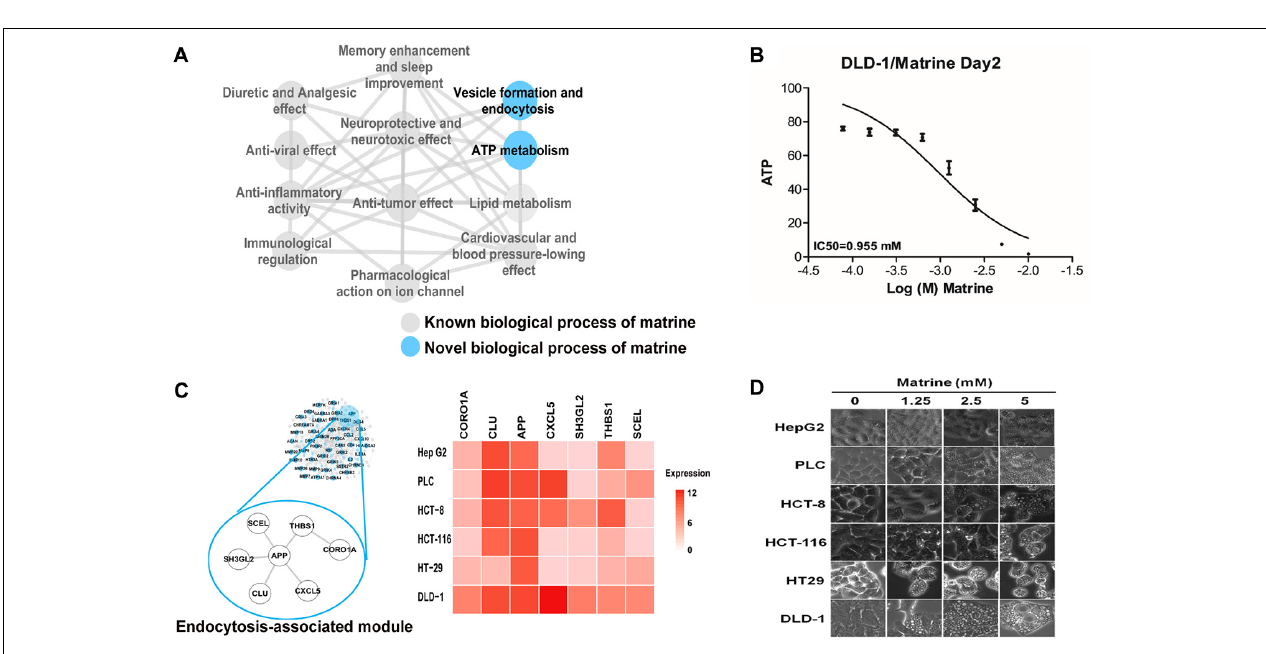
FIGURE 2 | Literature verification of the GO terms in BP category at all levels enriched from the network target of matrine. (A) The coverage rate of potential biological processes with literature evidence for matrine, which is defined as [the intersection of reported GO terms and enriched GO terms/the number of reported GO terms] × 100%. (B) Pie chart for the coverage rate of enriched GO terms in different classes from predicted targets of matrine covered by known biological processes of matrine. The coverage rate of each sector is calculated by [the intersection of reported GO terms and enriched GO terms/the number of enriched GO terms in one class] × 100%.